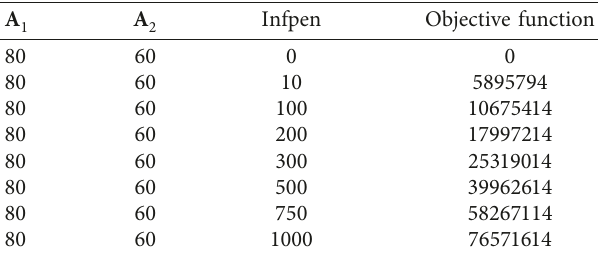
Figure 1: Changes in the objective function relative to the robustness factor. Table 15: Robustness analysis of the objective function relative to the amount of the